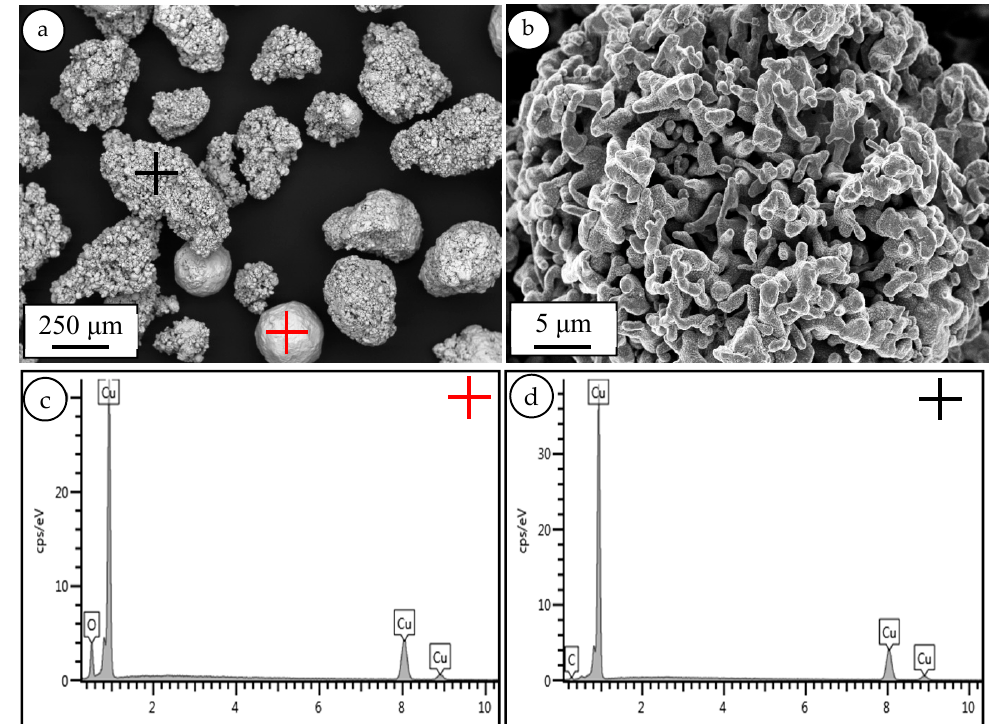
Figure 1. ( a – b ) SEM images of pure Cu powder with ( c – d ) the corresponding EDS analysis; the red Figure 1. ( a , b ) SEM images of pure Cu powder with ( c , d ) the corresponding EDS analysis; the red cross and black cross belong to the copper oxide and copper particle, respectively. cross and black cross belong to the copper oxide and copper particle,